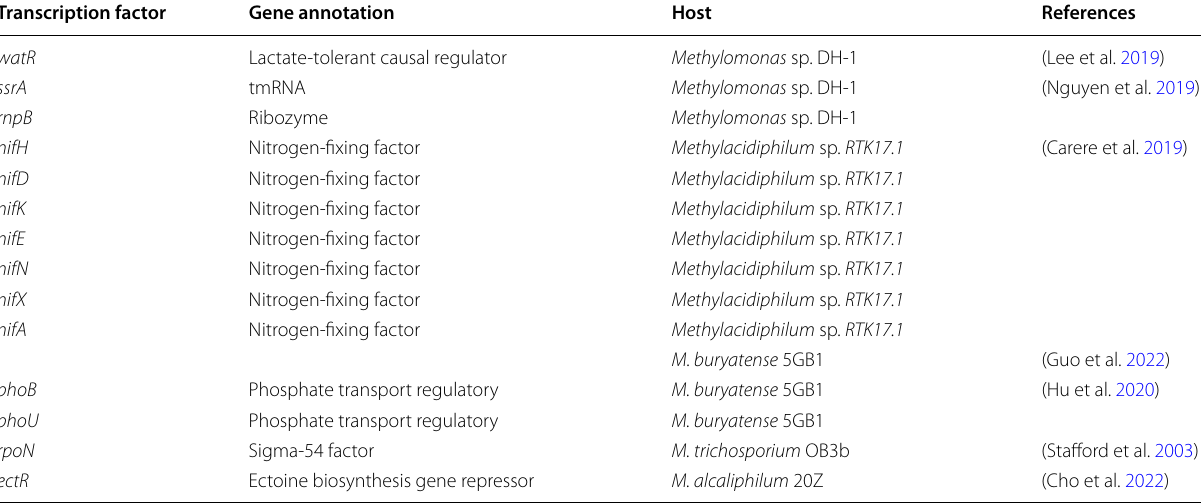
Table 2 Transcription factors reported in methylotrophic bacteria Transcription